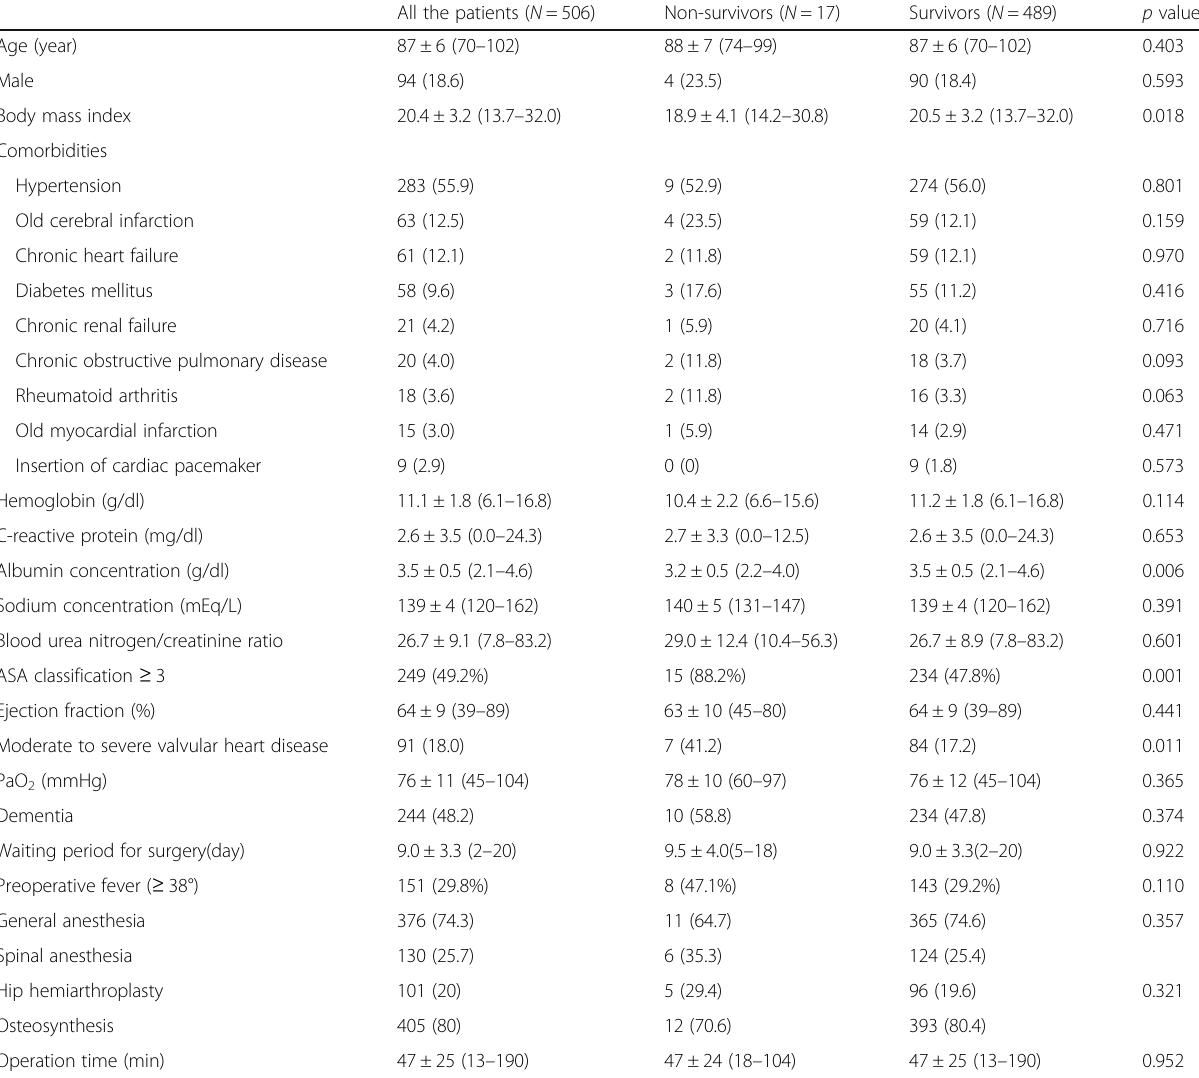
Table 2 Demographic data of the patients and comparison of clinical characteristics between the non-survivors and survivors All the patients ( N = 506)